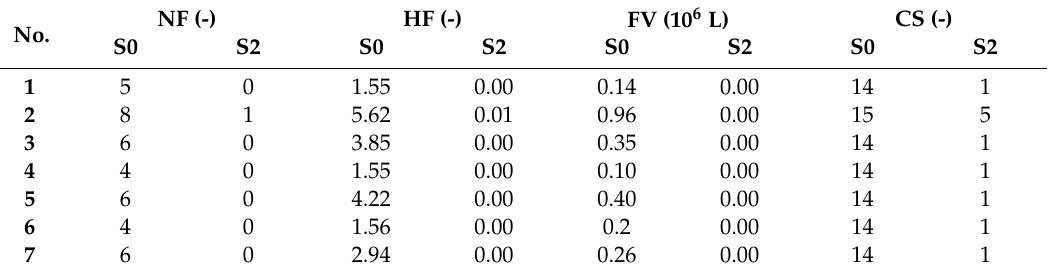
Table 8. Node Flooding (NF), Hours Flooded (HF), total Flood Volume (FV), and Conduits Surcharge (CS) for Scenario 0 (S0) and Scenario 2